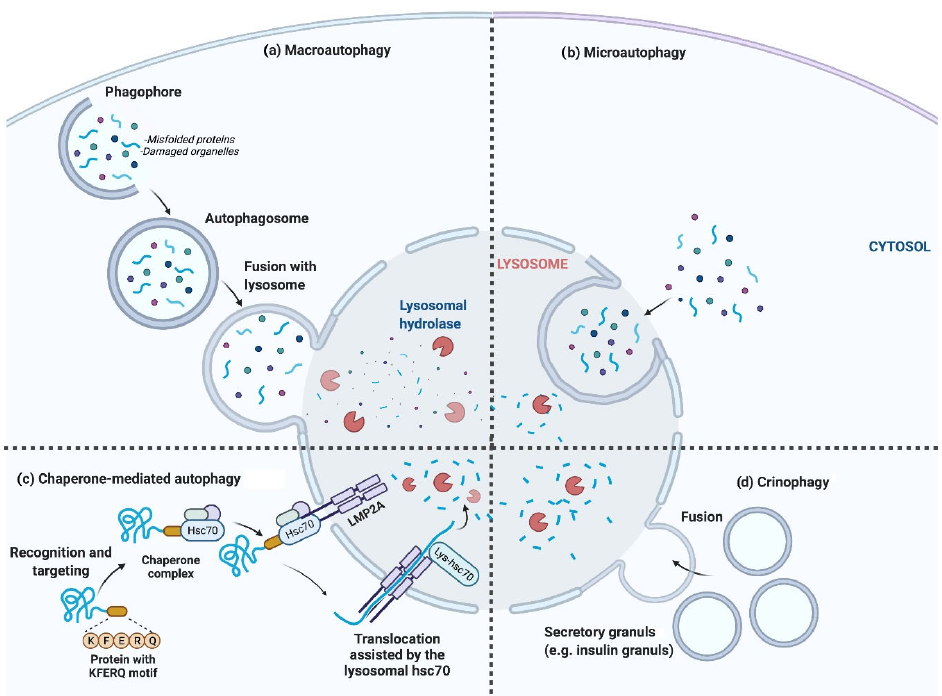
Figure 1. The four major types of autophagy. ( a ) Macroautophagy, generally termed autophagy; autophagosomes are formed and engulf cellular components, e.g., secretory granules. Autophagosomes finally fuse with lysosomes, after which the lysosomal hydrolases degrade the sequestered contents. ( b ) Microautophagy, in which cellular components are directly engulfed by the lysosomal membrane. ( c ) Chaperone-mediated autophagy, where specific amino acid sequence motifs of cytosolic proteins are recognized via the chaperone protein hsc70 and directly targeted to lysosomes for degradation. ( d ) Crinophagy, where secretory vesicles directly fuse with lysosomes